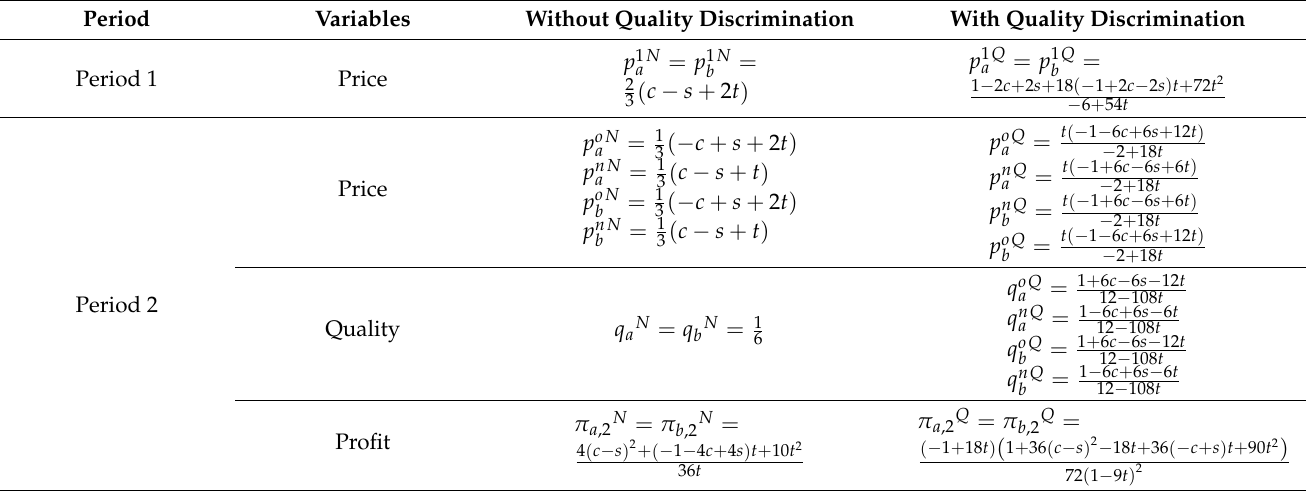
Table 2. Equilibrium results with or without quality